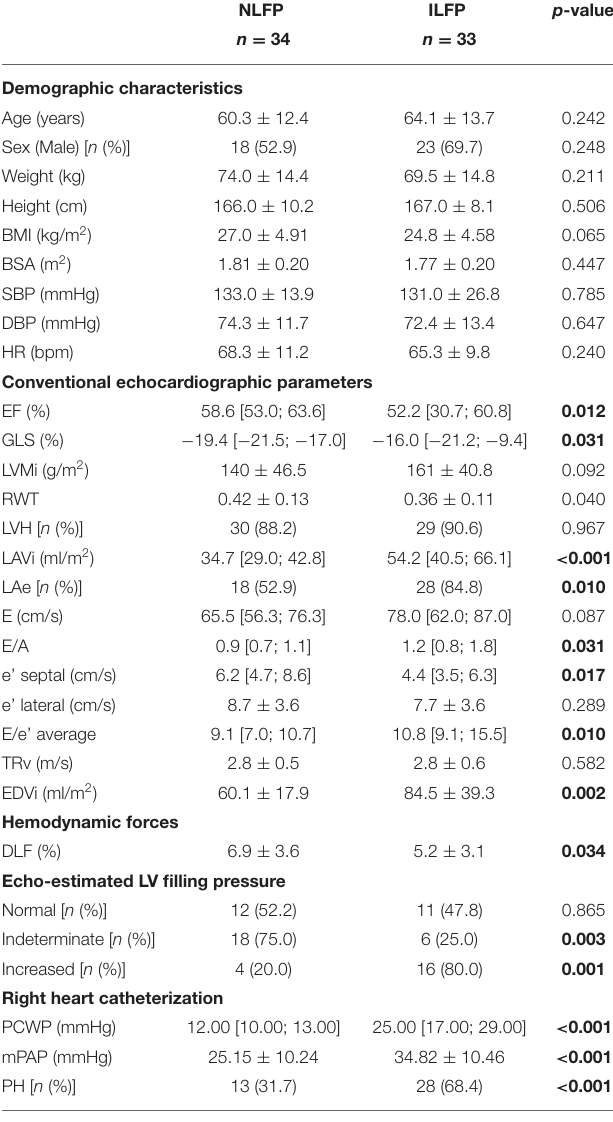
Significant p results between ILFP (increased left ventricular filling pressure) and NLFP (normal left ventricular filling pressure) are reported by boldface. BMI, body mass index; BSA, body surface area; SBP, systolic blood pressure; DBP, diastolic blood pressure; LVMi,leftventricularmassindexedtobodysurfacearea;LVH,leftventricularhypertrophy; LAVi, left atrial volume indexed to body surface area; LAe, left atrial enlargement; E, E wave on transmitral Doppler; E/A, E wave on transmitral Doppler/A wave on transmitral Doppler; e’ septal, septal tissue Doppler E wave; e’ lateral, lateral tissue Doppler E wave; E/e’ average, E wave on transmitral Doppler/mean tissue Doppler E wave; PAPm, mean pulmonary arterial pressure; TRv, tricuspidal regurgitation velocity; DLF, diastolic longitudinal